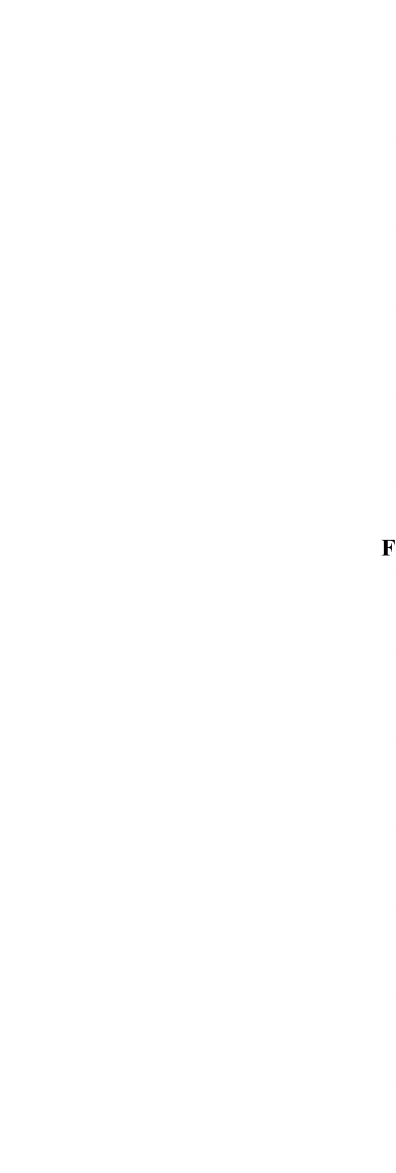
FIGURE 3 Heatmap of signi fi cantly altered cytokines, chemokines and related molecules showing the frequency of samples above the 90% speci fi city cut- off values for MS. Samples are classi fi ed in cluster 1 to 3 by k-means cluster analysis. Cytokines and chemokines are organized according to their frequency within the clusters. APRIL, a proliferation-inducing ligand; BAFF, B cell activation factor; BLC, B lymphocyte chemoattractant; CD40L, CD40 ligand; ENA-78, epithelial neutrophil-activating peptide-78; FGF, fi broblast growth factor; G-CSF, granulocyte colony-stimulating factor; GM-CSF, granulocyte-macrophage colony-stimulating factor; GRO, growth-regulated oncogene; HGF, hepatocyte growth factor; IFN, interferon; IL, interleukin; IP, interferon- ɣ -induced protein; I-TAC, interferon-inducible T cell a -chemoattractant; LIF, leukemia inhibitory factor; MCP, monocyte chemoattractant protein; M-CSF, macrophage colony-stimulating factor; MDC, macrophage-derived chemokine; MIF, macrophage migration inhibitory factor; MIG, monokine induced by interferon- ɣ ; MIP, macrophage in fl ammatory protein; MMP, matrix metalloproteinase; MOGAD, myelin oligodendrocyte glycoprotein associated disease; MS, multiple sclerosis; NGF, nerve growth factor; NMOSD, neuromyelitis optica spectrum disorder; SCF, stem cell factor; SDF, stromal cell-derived factor; TNF, tumor necrosis factor; TRAIL, TNF-related apoptosis-inducing ligand; TSLP, thymic stromal lymphopoietin; TWEAK, tumor necrosis factor-like weak inducer of apoptosis; VEGF, vascular endothelial growth